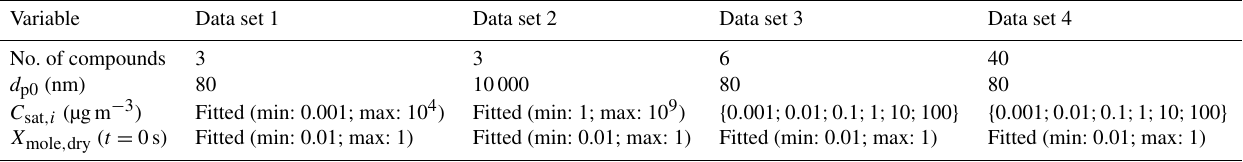
Table 1. Characteristics for the artificial data sets. Properties from top to bottom are number of VBS compounds (bins), particle diameter at the start of the evaporation, saturation concentrations of the VBS compounds and dry mole fraction of the compounds at the start of the evaporation. For C sat and X mole , dry “fitted” means that the parameter value was used as a fitting parameter and the value was constrained between the reported minimum and maximum values.